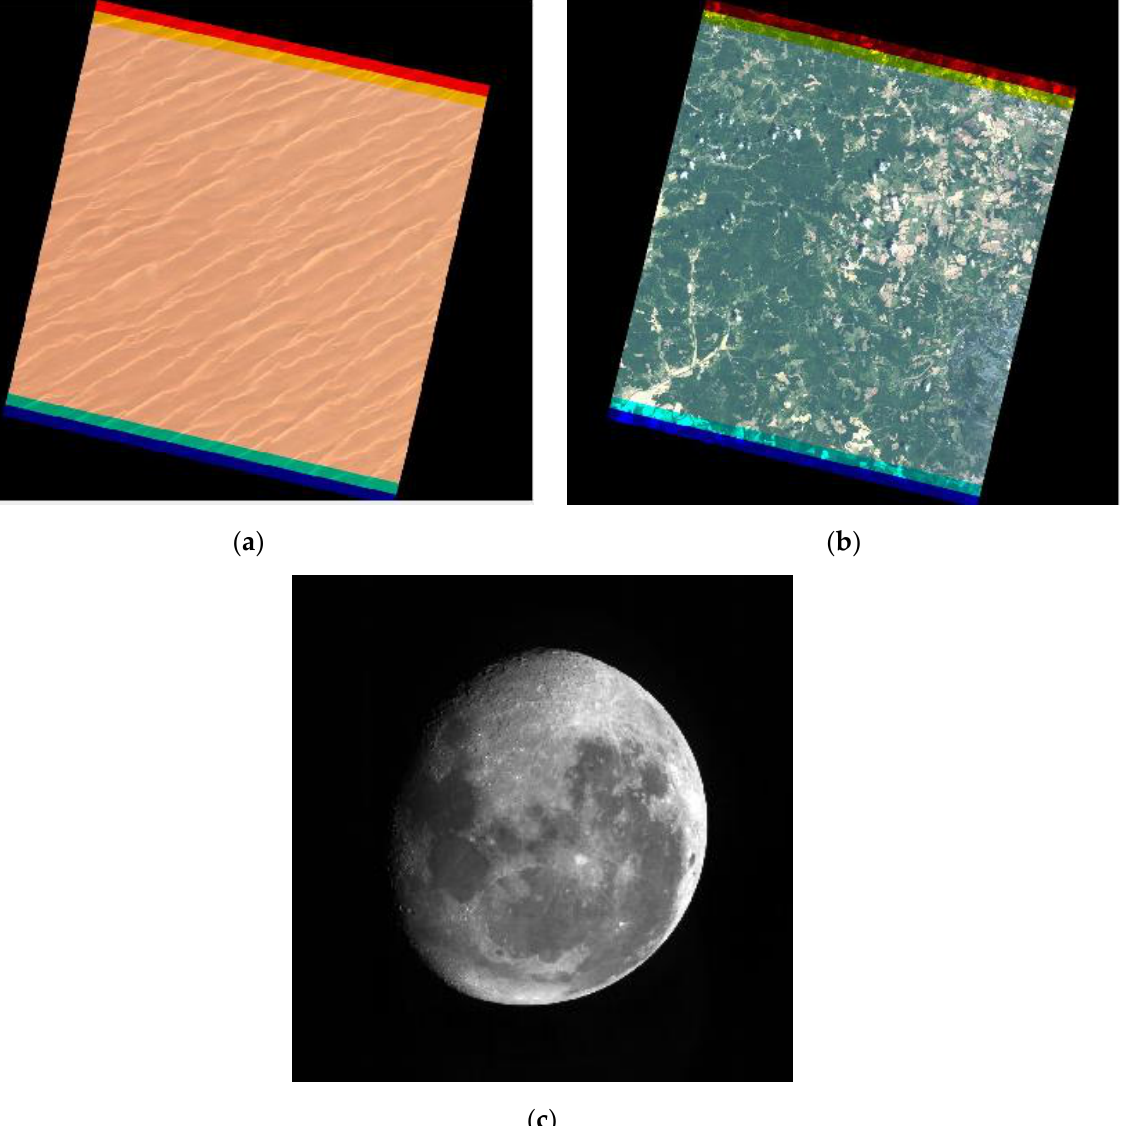
Figure 8. ( a ) RGB image over the desert site Arabia 1; ( b ) RGB image over the SNO site in Kentucky; ( c ) Moon image.